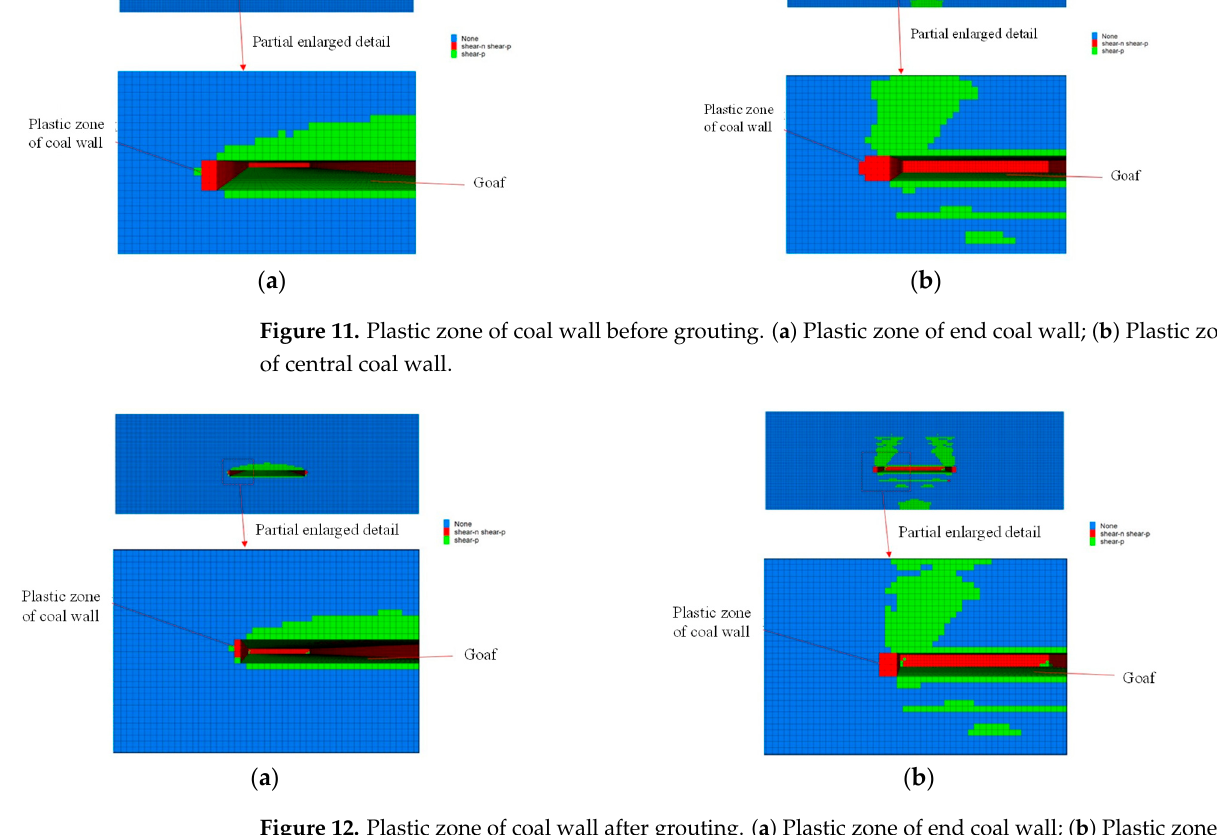
Figure 11. Plastic zone of coal wall before grouting. ( a ) Plastic zone of end coal wall; ( b ) Plastic zone of central coal wall.